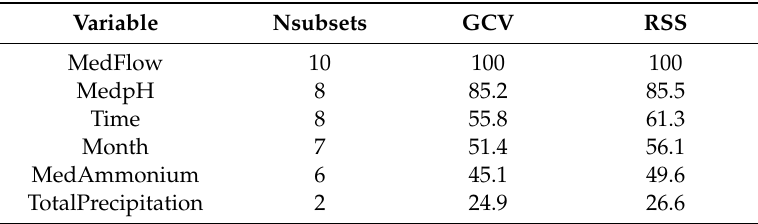
Table 4. Importance assessment of variables in the